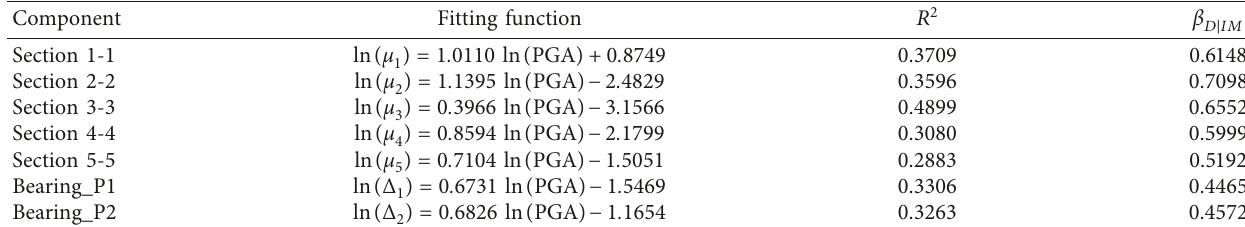
Figure 7: Regression analysis of different component response under earthquake excitation. (a) Section 1-1. (b) Bearing_P1. Table 3: Probabilistic demand model for seismic response at each critical component location.